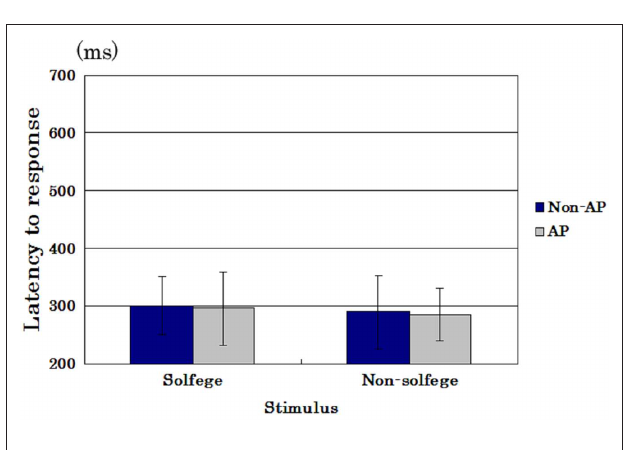
Figure 2 | Mean latency (error bars: SDs) of AP possessors and of non-AP possessors in the hearing session to press the button when the presented stimuli were solfege syllables as well as non-solfege